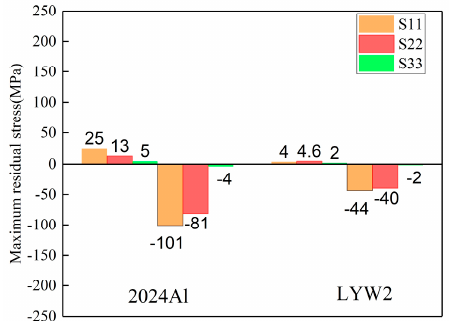
Figure 16. Maximum stresses of as-quenched 2024Al and W/2024Al blocks with the thickness of 9 mm.